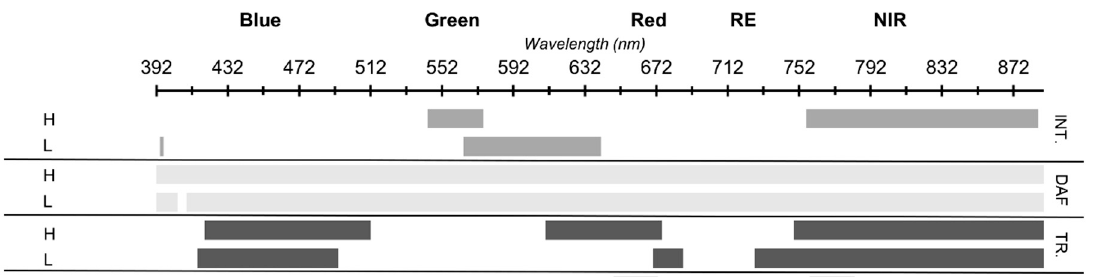
Figure 4. Probabilities corresponding to the interaction of the frost treatment and DAF on the spectral response. Horizontal dashed line is at p = 0.05.